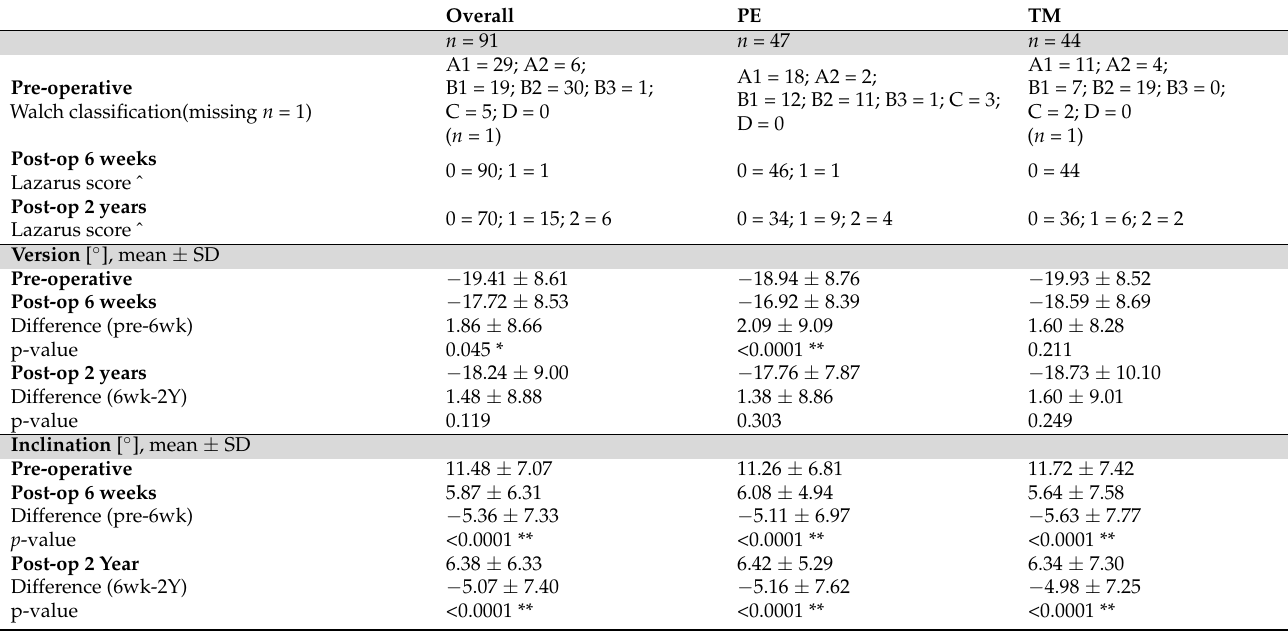
Table 1. Preoperative glenoid wear (Walch classification) assessment of the native glenoid and glenoid component radiolucency (Lazarus classification [16]) at 6-week and 2-year follow-up. Glenoid version and inclination, overall and by glenoid component type (PE and